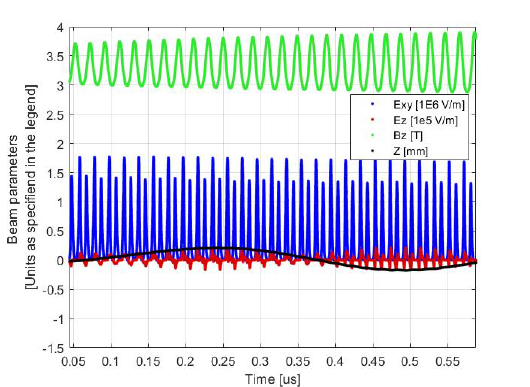
Figure 20. Details of beam transverse displacement evolution, magnetic field and electric field compo- nents during the first part of the acceleration inside the cyclotron. Asymmetric shorts configuration.